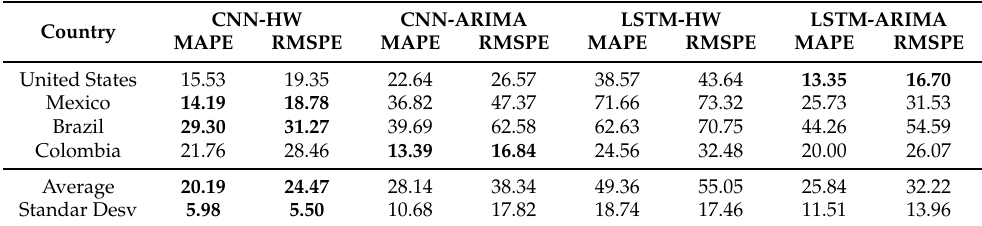
Table 2. CNN–CT methods performance. Best MAPE results are marked in bold.